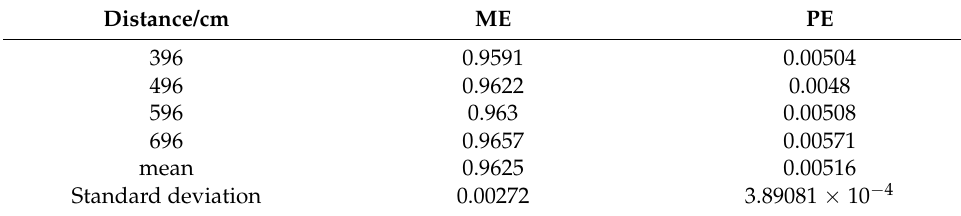
Table 4. ME amplitudes and phase errors (12 April